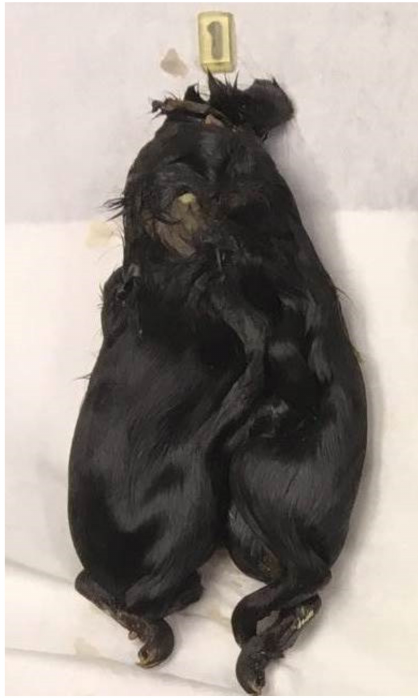
Figure 1. The conjoined